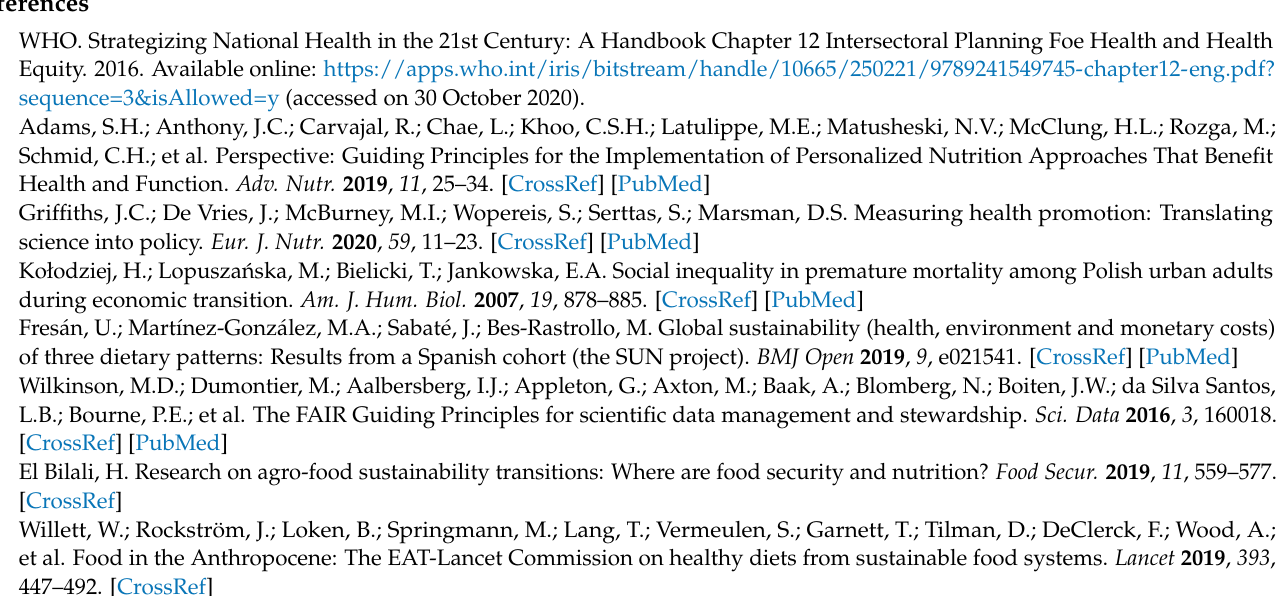
of Partecipants. Table S2: Characteristics of Participants by modified WCRF/AICR Score Categories MICOL/PANEL Studies. Table S3: Characteristics of Participants by modified WCRF/AICR Score Categories NUTRIHEP Study, Putignano (BA), Italy, 2005–2018. Table S4: Sensitivity analysis to obtain age at death range. All-cause mortality MICOL/PANEL and NUTRIHEP studies. Castellana Grotte, Putignano (BA), Italy, 2005–2017. Table S5: Sensitivity analysis to obtain age at death range. MICOL/PANEL and NUTRIHEP studies. Castellana Grotte, Putignano (BA), Italy, 2005–2017. Table S6: Mortality Rates (MR) and 95% Confidence Intervals (95% CI) for all-cause mortality, for DSD-related mortality, CVD-related and other-causes Mortality from modified